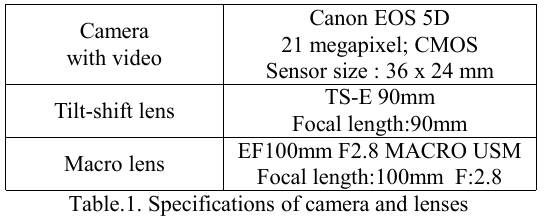
Table.1. Specifications of camera and